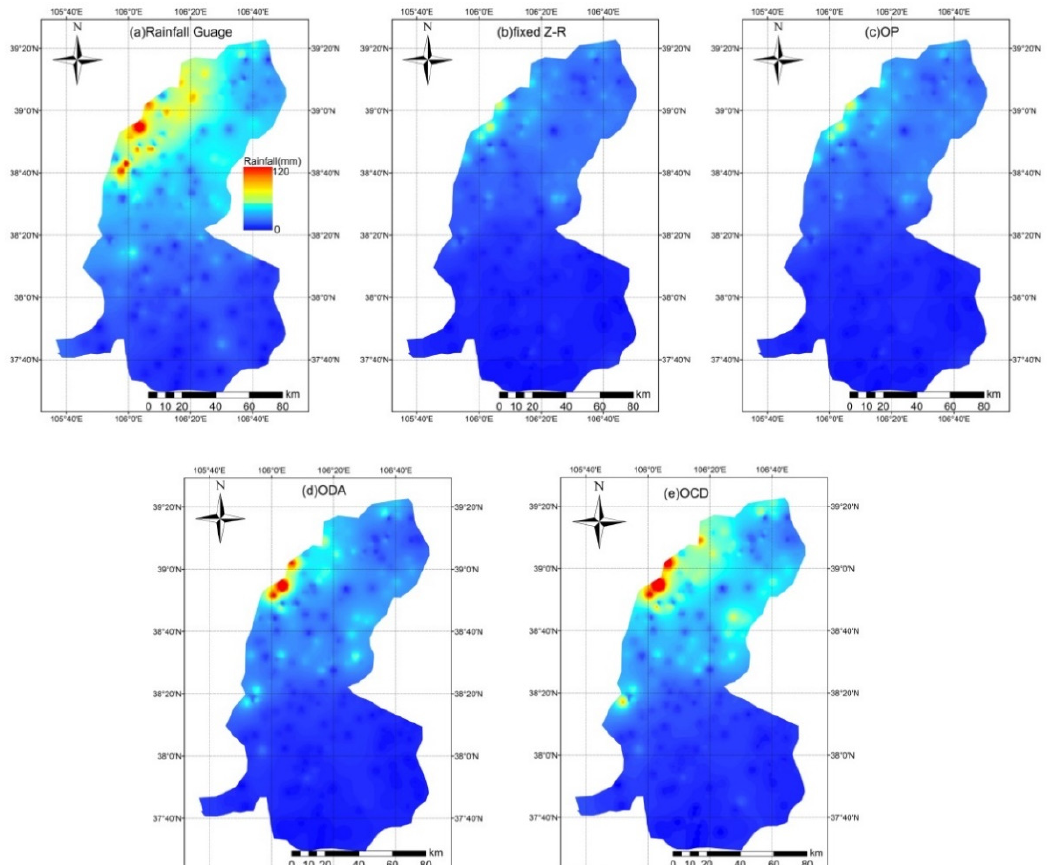
Figure 8. Spatial distribution of rainfall in 2018/7/22, (a) interpolation of rain gauge observations, (b)fixed Z-R for radar, (c)OP for radar, (d)ODA for radar and (e)OCD for radar.